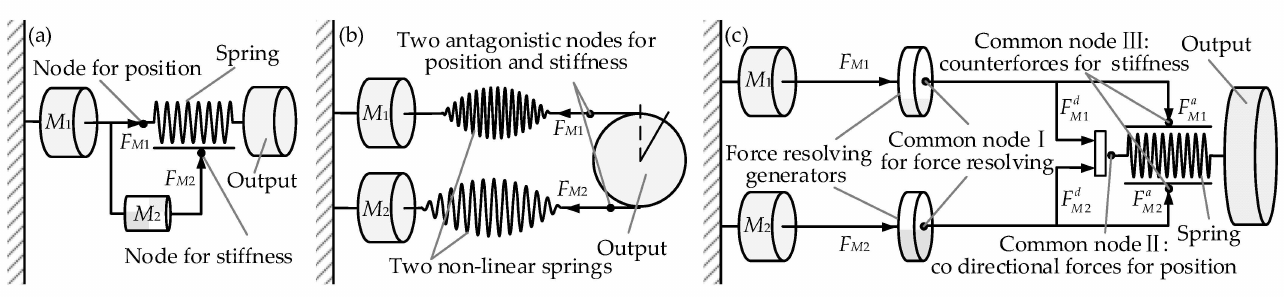
Figure 1. VSA categories based on load distribution ( a ) Independent mode; ( b ) Antagonistic mode; ( c ) Helping mode (the type